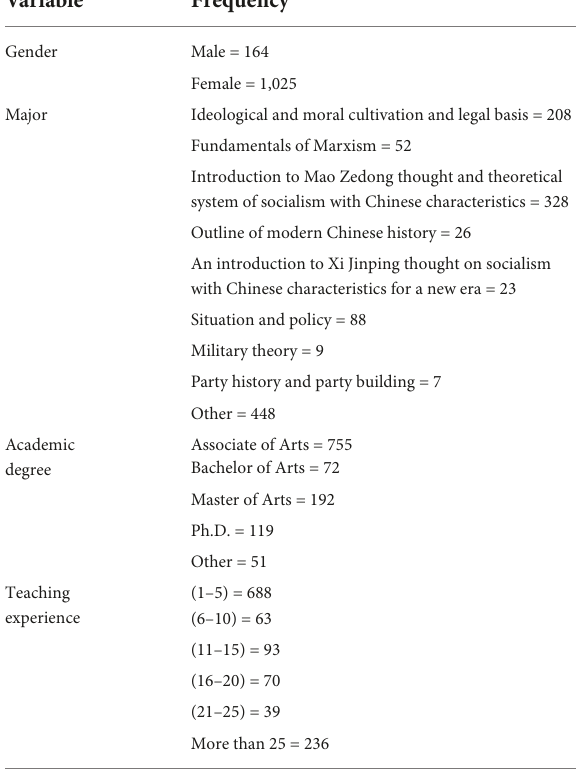
TABLE 1 Demographic information of the